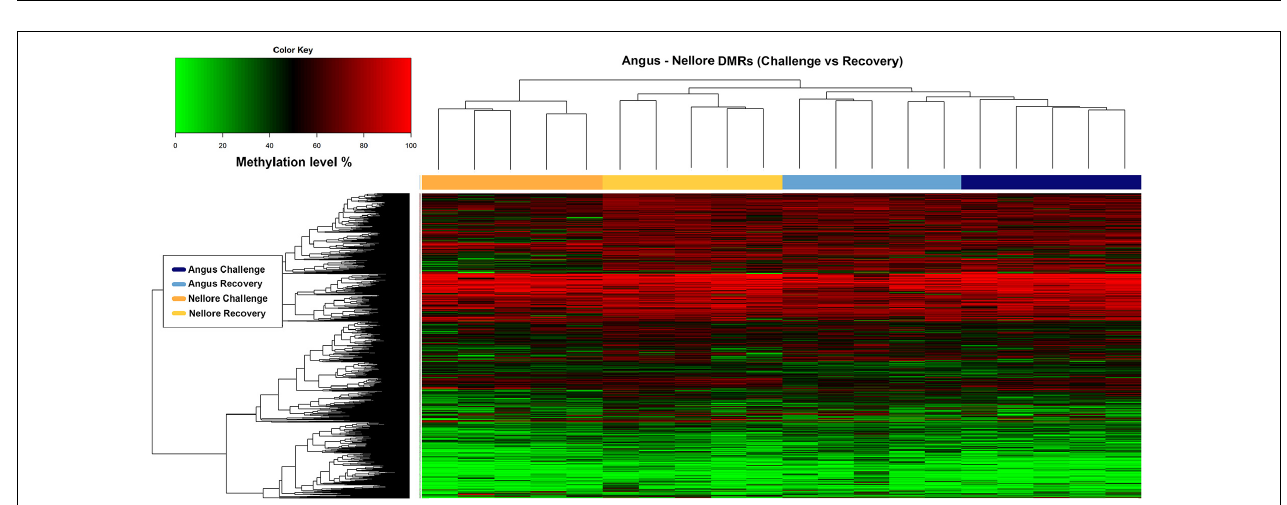
FIGURE 3 | Venn diagram of differentially methylated windows in Angus and Nellore (C, Challenge, R, Recovery).